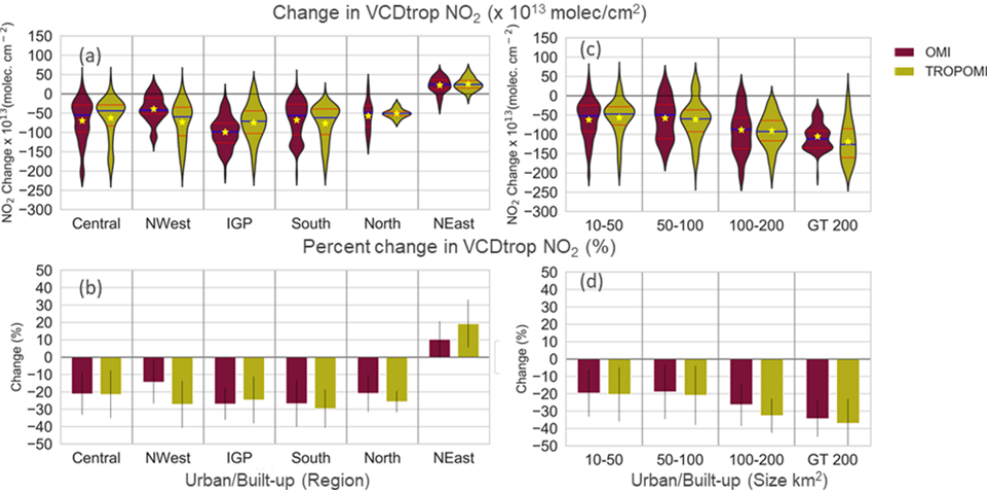
Figure 6. Observed change in VCD trop NO 2 between LDN and BAU from OMI and TROPOMI for different regions shown as (a) a violin plot of the absolute change over urban areas, (b) the percentage change over the urban area, (c) a violin plot of the observed change over different sized urban areas, and (d) the percentage change over different sized urban